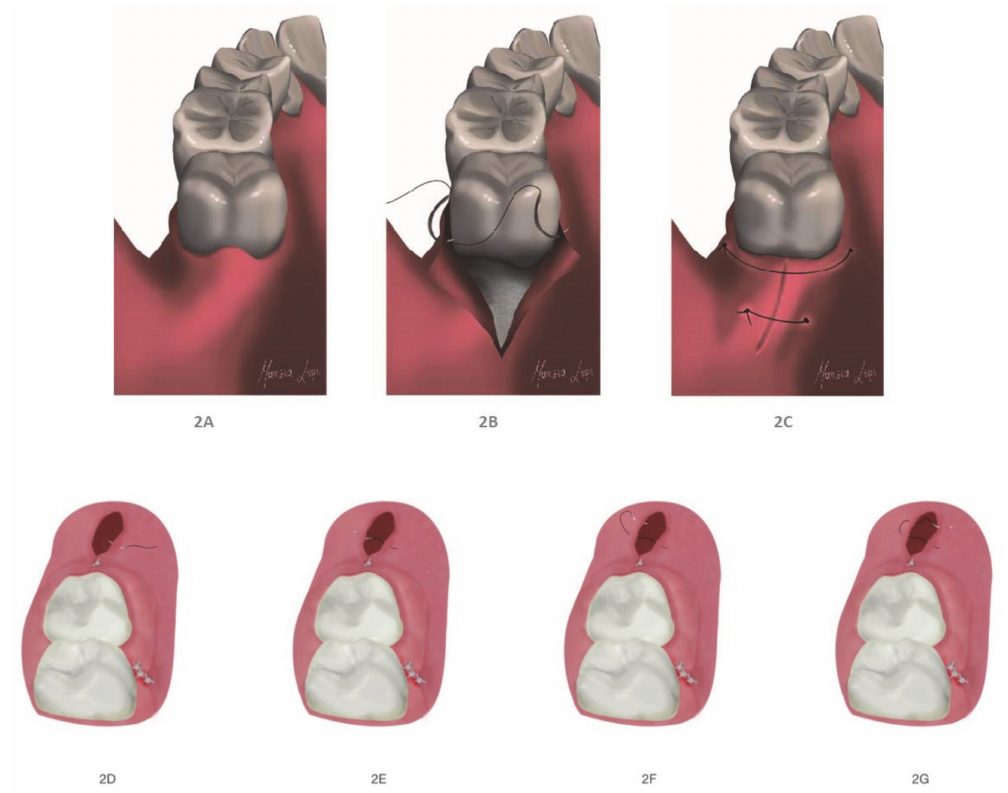
Figure 2. ( A , B ) The pre- and post-modified interrupted suture; ( C ) the modified interrupted suture; ( D – G ) the external horizontal mattress